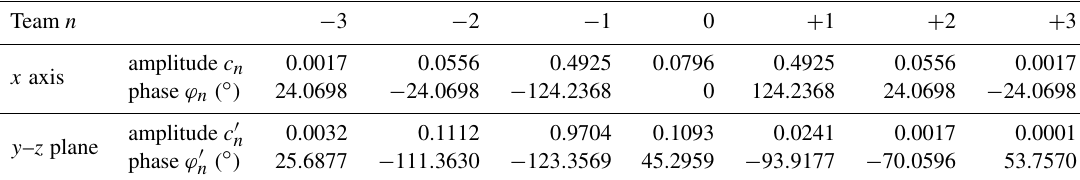
Table 8. The amplitude and phase of the RBPO of the 10th group of the MPBDT. Team n − 3 − 2 − 1 0 + 1 + 2 + 3 amplitude c x axis